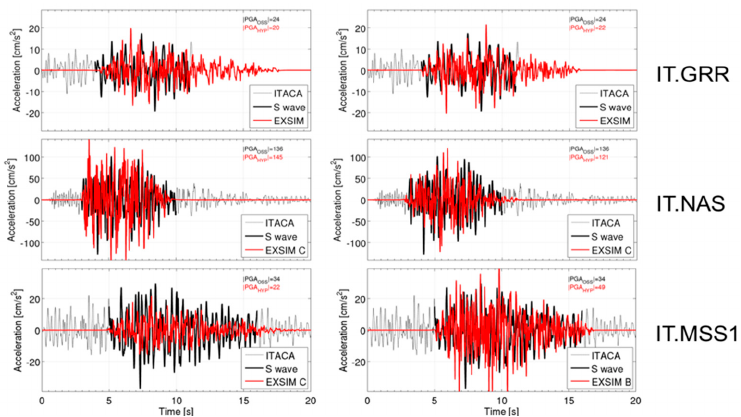
Figure 10. Examples of two acceleration time series extracted from HYPST_syn_db by matching the waveforms (EW component) recorded by the stations IT.GRR, IT.NAS, and IT.MSS1 during the 1978 Patti Gulf earthquake, M W = 6.0. Black dotted line, full waveforms from ITACA archive http://itaca.mi.ingv.it/; black line, S-wave time windows of the recorded data; red line, simulated data. Absolute values of the peak ground acceleration for both the recorded and simulated ground-motion amplitudes are also reported.